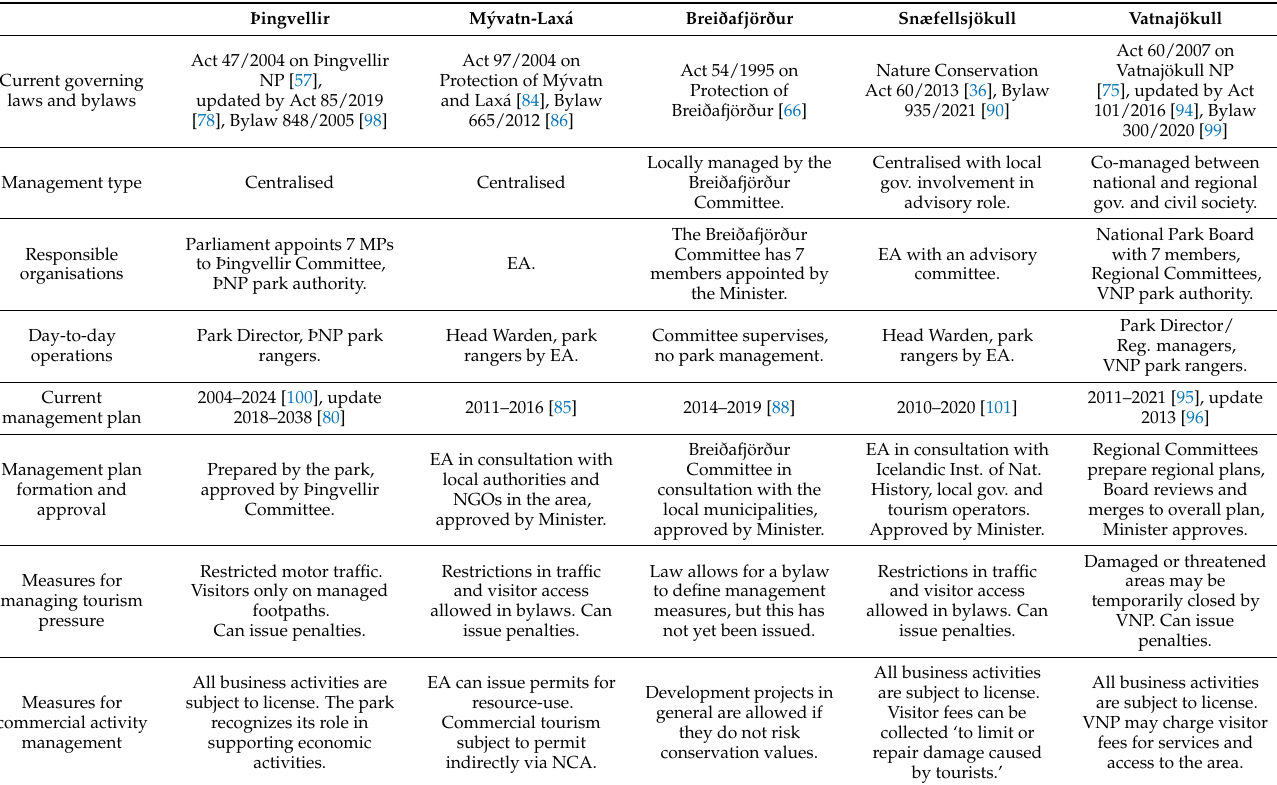
Table 2. Comparison of the governance setup for selected protected